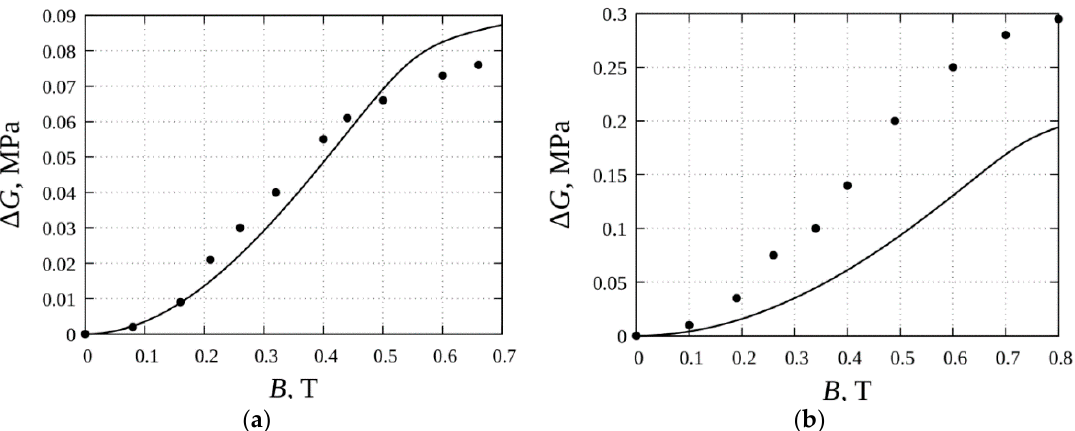
Figure 3. The magnetically induced part ∆ G of the shear modulus vs. the flux density B in the composite. Lines—theory, dots—experiment [44]. The shear modulus of the matrix G 0 = 60 kPa; the initial magnetic susceptibility of the particle material χ p = 100; the saturated magnetization of the particle material M s = 1670 kA/m; the volume concentration of the particles φ = 0.1 ( a ) and φ = 0.2 ( b ).